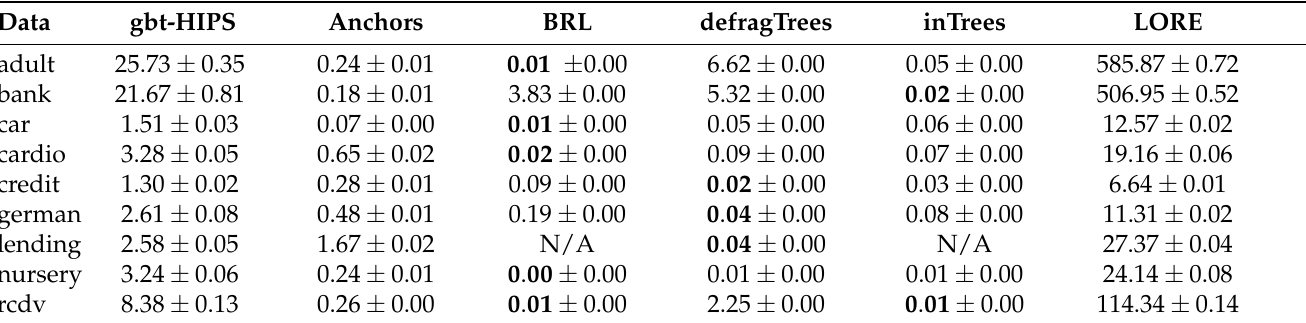
Table 8. Mean elapsed time of explanations of the stochastic GBT